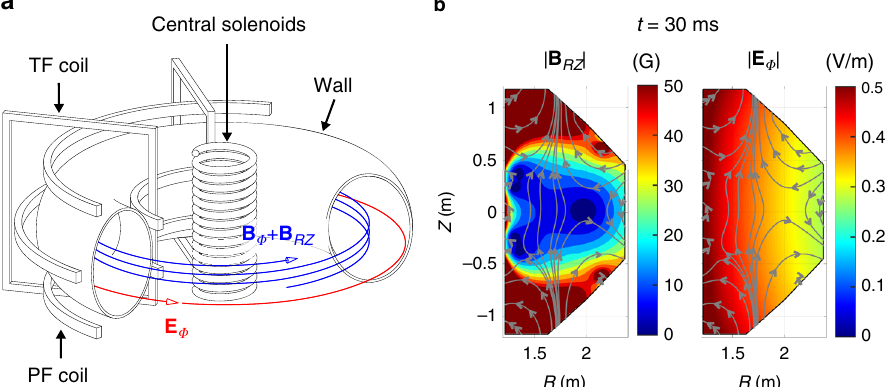
Fig. 1 Schematic diagram of ohmic breakdown. a The tokamak device consists of a donut-shaped axisymmetric wall and several coil segments. TF (Toroidal Field) coils produce strong static toroidal magnetic fi elds ( B ϕ ), and central solenoids swing their currents to induce the toroidal electric fi elds ( E ϕ ) by Faraday ’ s law to make the electron avalanche. The toroidal electric fi elds induce eddy currents in the wall, the eddy currents and central solenoids' currents produce undesirable stray vertical magnetic fi elds ( B RZ ) in the RZ plane. The time-varying current waveforms of the PF (Poloidal Field) coils are designed to provide vertical magnetic fi elds that cancel out the stray magnetic fi elds effectively. As a result, very weak vertical magnetic fi elds (| B RZ |~10 − 3 T) and strong toroidal magnetic fi elds (| B ϕ | ~ 1 T) comprise helical magnetic fi elds ( B ϕ + B RZ ) of the complex structure. The helical fi elds have very small pitch angles ( θ B ~10 − 3 rads) and open to the walls with very long connections lengths (~10 3 m). b A snapshot of the complex electromagnetic (EM) structures in the RZ plane in a KSTAR reference breakdown scenario at t = 30 ms. Gray lines and arrows indicate the magnetic fi eld lines. Color contours show the magnitudes of (left) B RZ in Gauss unit (1 G = 10 − 4 T) and (right) E ϕ in V m − 1 unit. The EM structures are strongly inhomogeneous and change dynamically during the ohmic breakdown (see Supplementary Fig. 1 for more